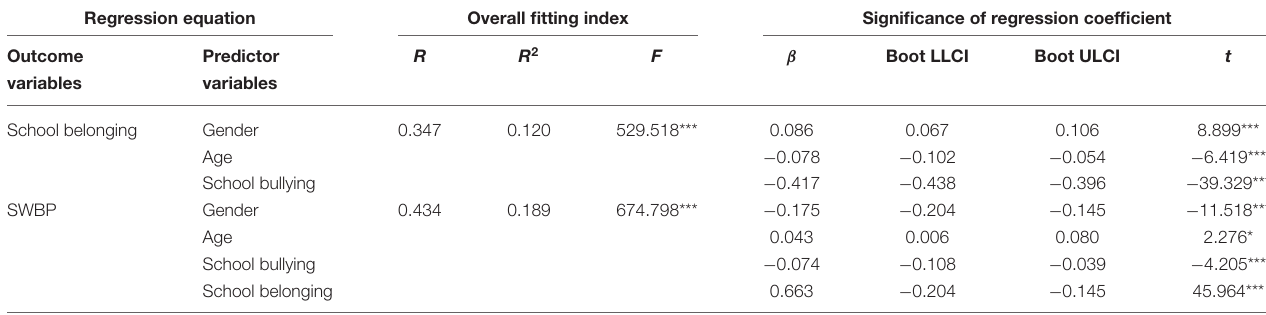
TABLE 4 | The mediation effect model test results. Regression